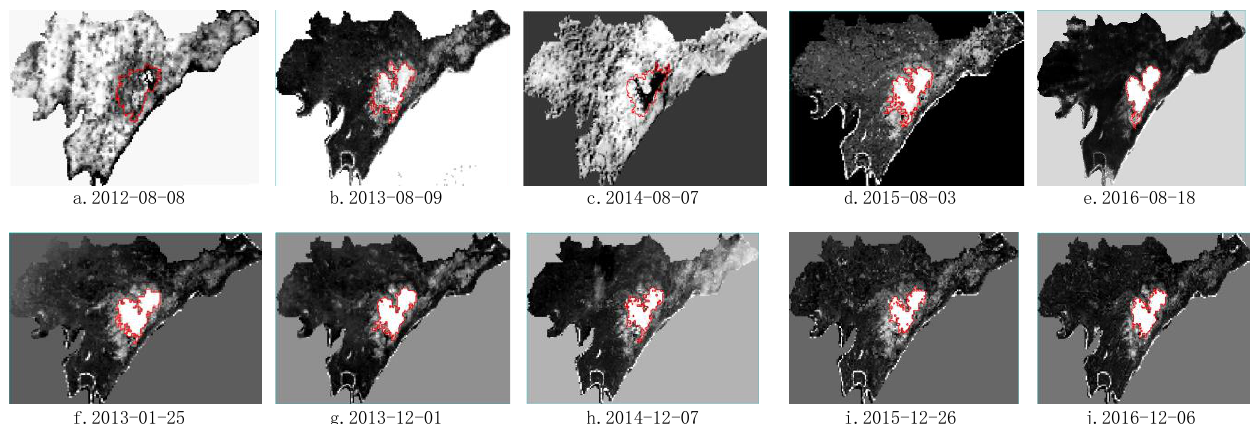
Figure4: The area changing of Hong Lake’s comparison by using NDVI and NDWI method to extract from 2012 to 2016, the date of each chart under the picture represents the date of corresponding